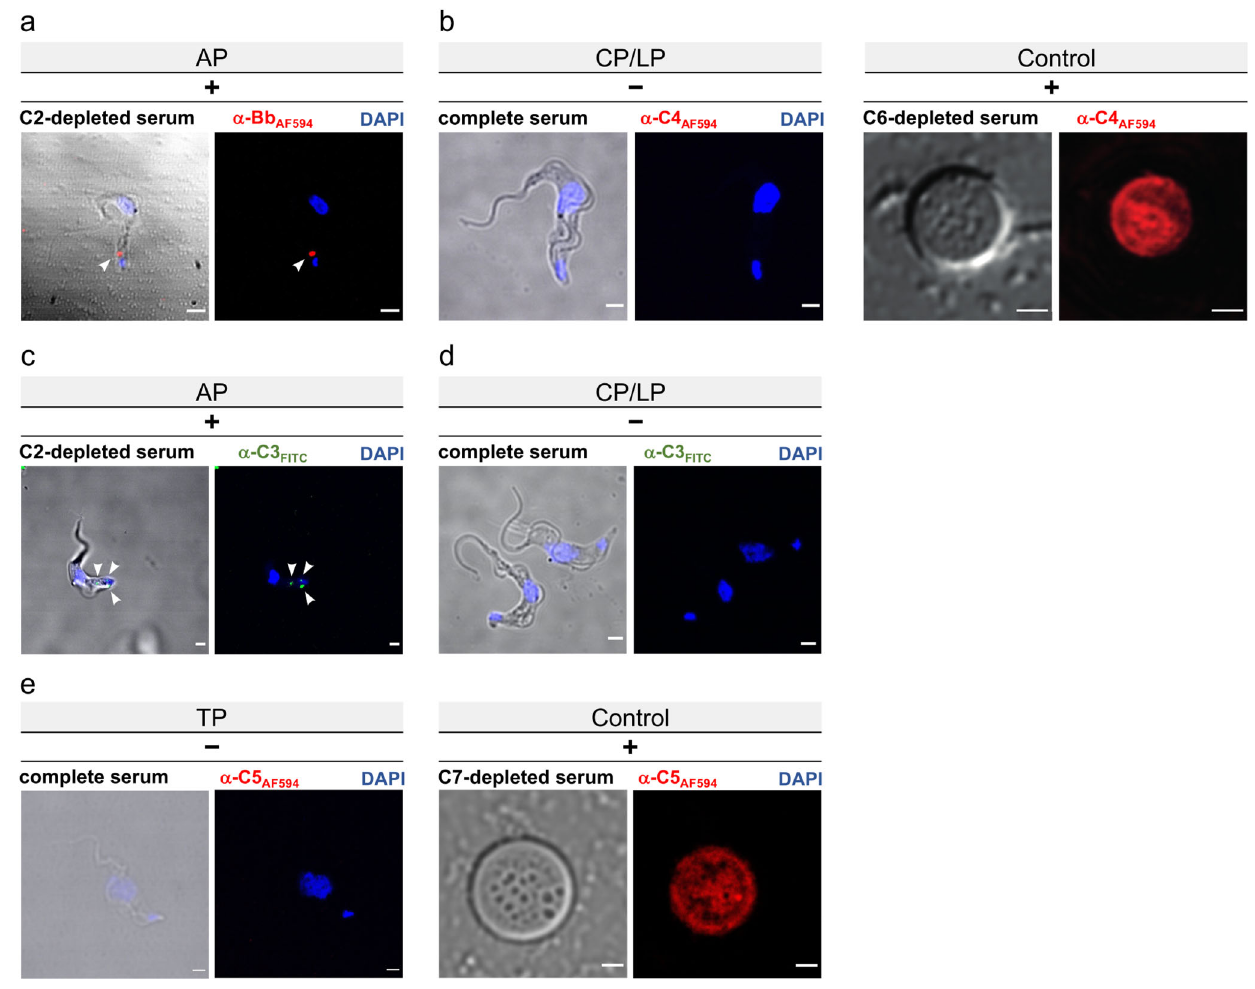
Fig. 3 | Bb and C3b are deposited on the surface of T. bruceigambiense in a C2- independent manner, while C4b and C5b are not detected by immuno- fl uorescence. Representative fl uorescence micrographs of trypanosomes incu- batedin depletedor completehuman serumtested for deposition of complement factors using fl uorescently-labelled antibodies as indicated (red=AF594, green= FITC; blue=DAPI stain; left images are merged with bright fi eld channel; scale bar=2 μ m). Independent experiments were performed at least in triplicate. Note, that even at low temperatures, molecules bound to the trypanosome surface are rapidly internalised, accumulating in the fl agellar pocket before delivery to the earlyendosome.Flagellarpocket,earlyendosomeandlysosomearehighlightedby whitearrowsonselectedimages. a T.b.gambiense inC2-depletedserum(noCP/LP)